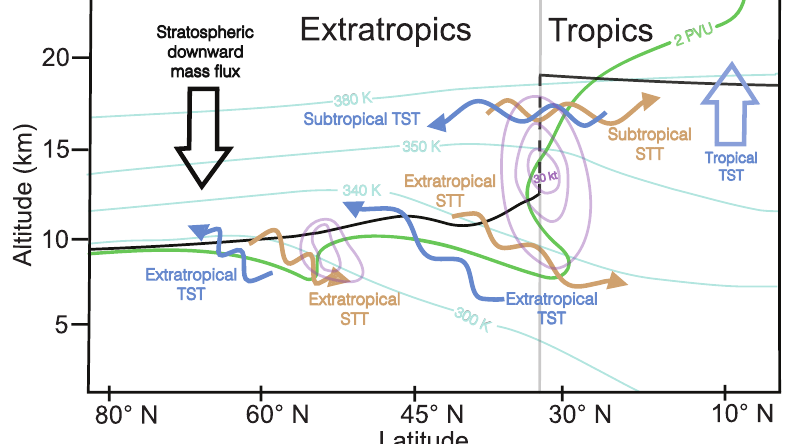
Figure 1. Hemispheric schematic of the STE identification method employed in this study. STT and TST are shown by orange and blue arrows, respectively. Bold and wavy arrows represent the Brewer–Dobson circulation and quasi-isentropic mixing processes, respectively. Potential temperature surfaces are given by the cyan lines, the lapse-rate tropopause by the black lines, and the 2PVU potential vorticity (PV) isosurface by the green line. The solid gray line, coincident with the tropopause break (dashed black line), represents the boundary between the tropics and extratropics. Subtropical and polar jet streams are shown by solid purple